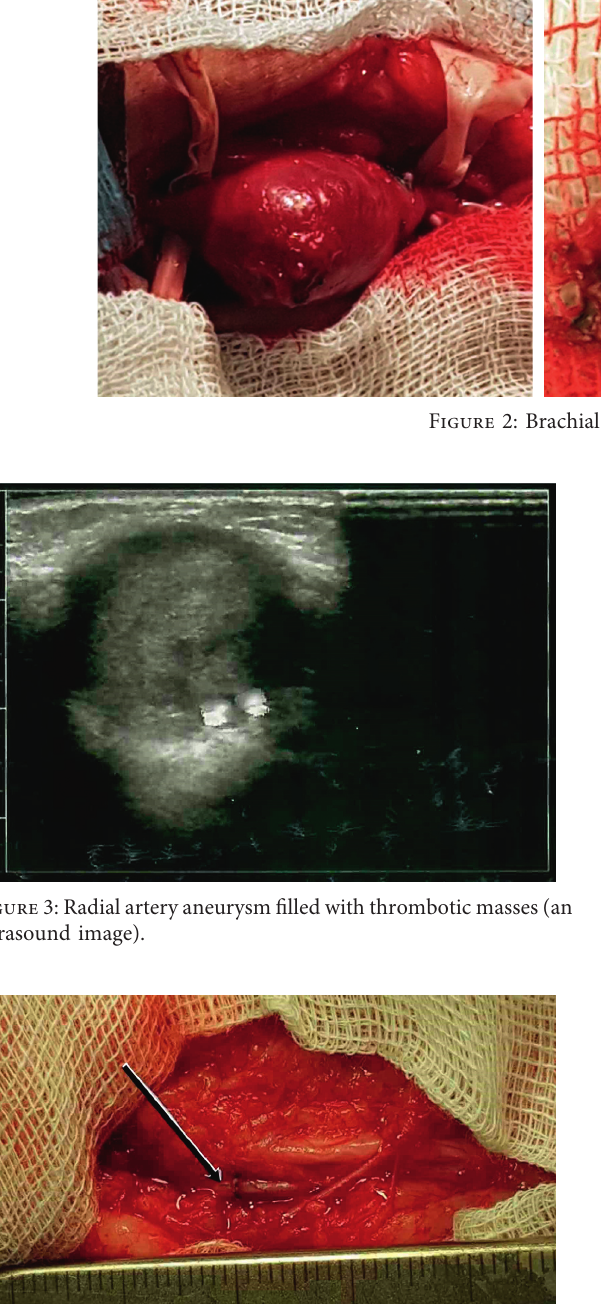
Figure 6: Autovenous graft dilated (an ultrasound image).